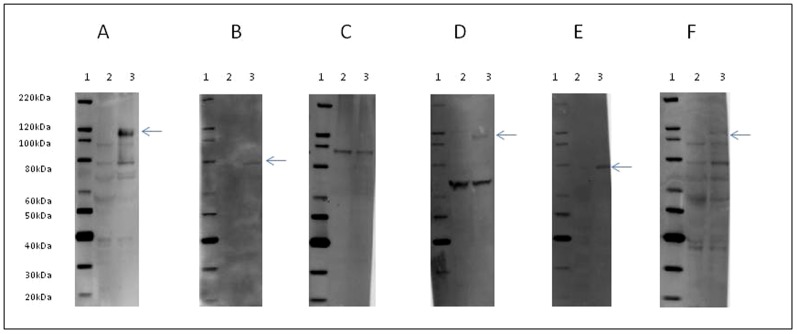
Antibody responses from vaccinated A129 and 129Sv/Ev mice.Sera from vaccinated mice were tested for reactivity with CCHFv-infected (lane 3) or uninfected (lane 2) SW13 cells by Western blotting. Lane 1 shows a molecular weight marker. Blots show proteins reactive with serum from representative individual animals 7 days after booster vaccination (A–E) or representative pooled serum 14 days after booster vaccination (F). Secondary antibody used was specific for mouse IgG (A–C, F), or mouse IgG, IgA and IgM (D–E). Arrows highlight CCHFv-specific proteins, indicating specific antibody responses in both mouse strains. (A) 129Sv/Ev mouse vaccinated with MVA-GP. (B, D–E) A129 mouse vaccinated with MVA-GP. (C) A129 mouse vaccinated with MVA 1974. (F) Pooled sera from A129 mice vaccinated with MVA-GP.